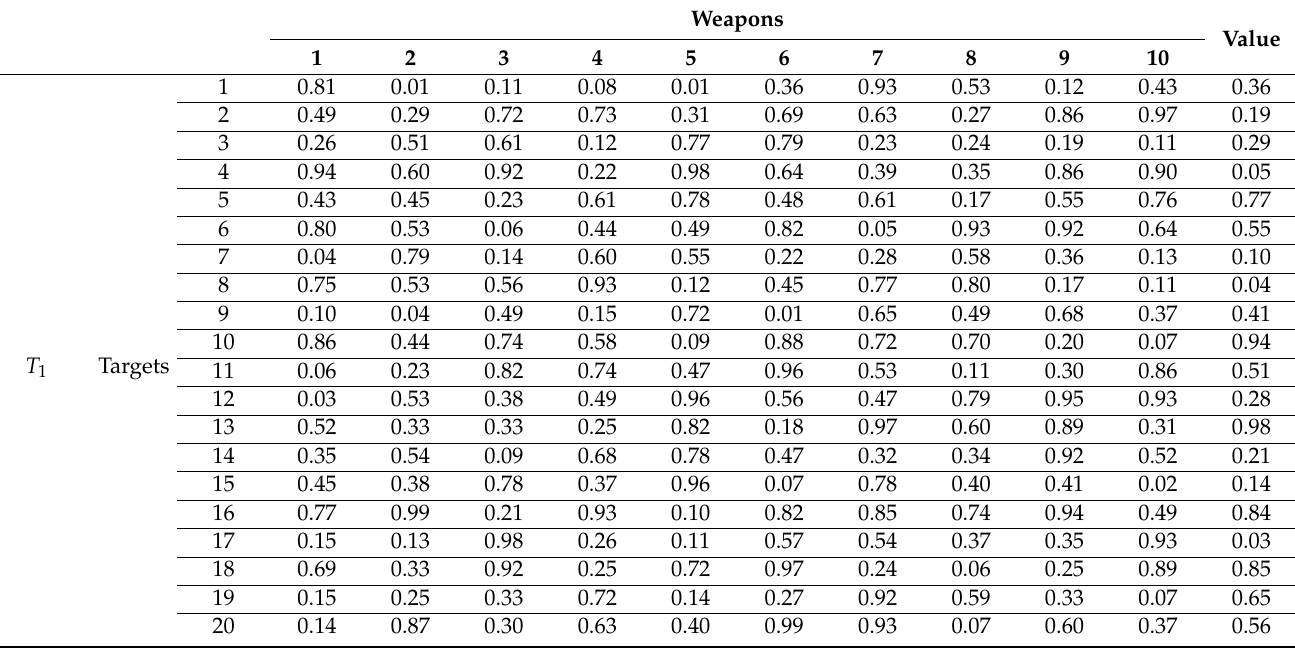
Table A9. Details of the destructive value of every target and the probability of kill for every weapon in the two component tasks of problem 9 in Table 2. Each task is a WTA